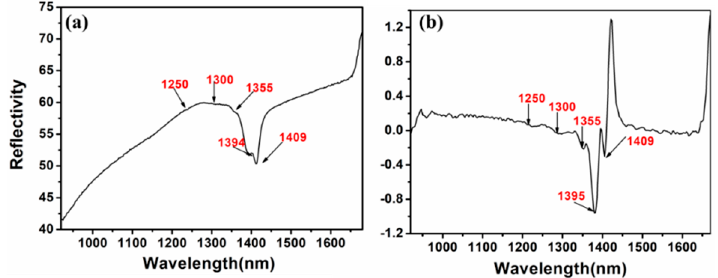
Figure 1. The near-infrared (NIR) spectrum of soil: ( a ) original spectrum; ( b ) first-order spectrum.